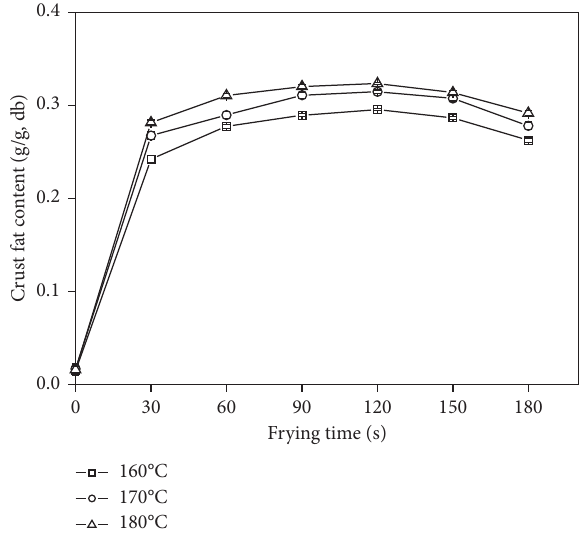
Figure 2: Crust fat content of BBFNs fried at different